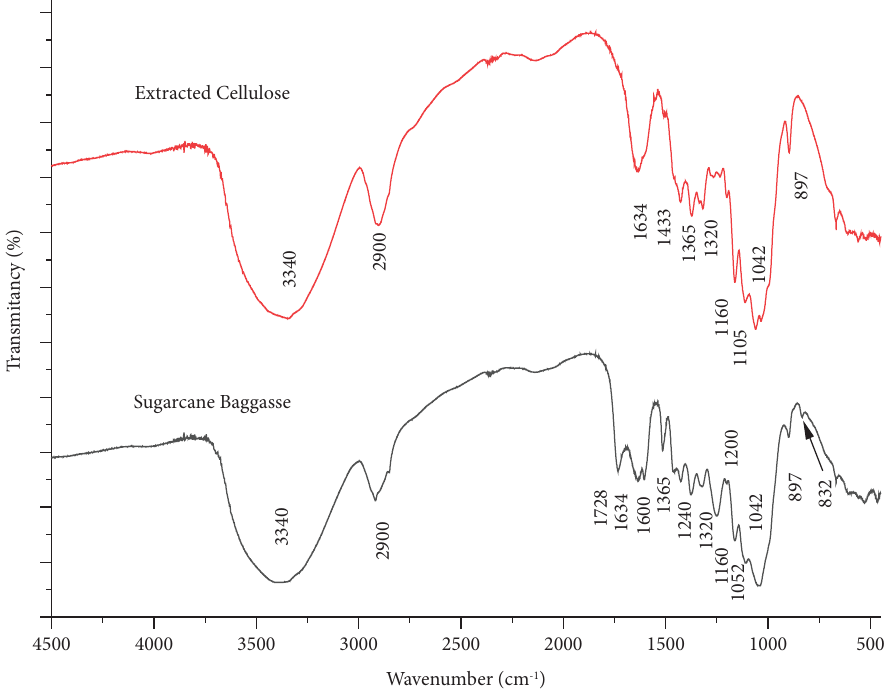
Figure 6: FTIR spectra of untreated sugarcane bagasse and extracted